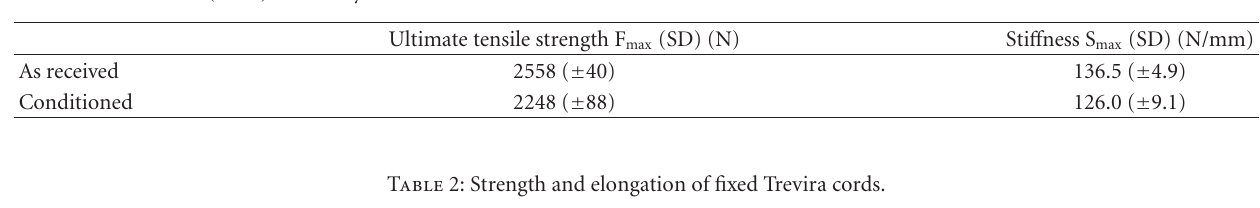
Table 1: Mean ultimate tensile strength and mean sti ff ness of the investigated fixation mechanism with Trevira cords. Tested as received and conditioned in saline (37 ◦ C) for 25 days.